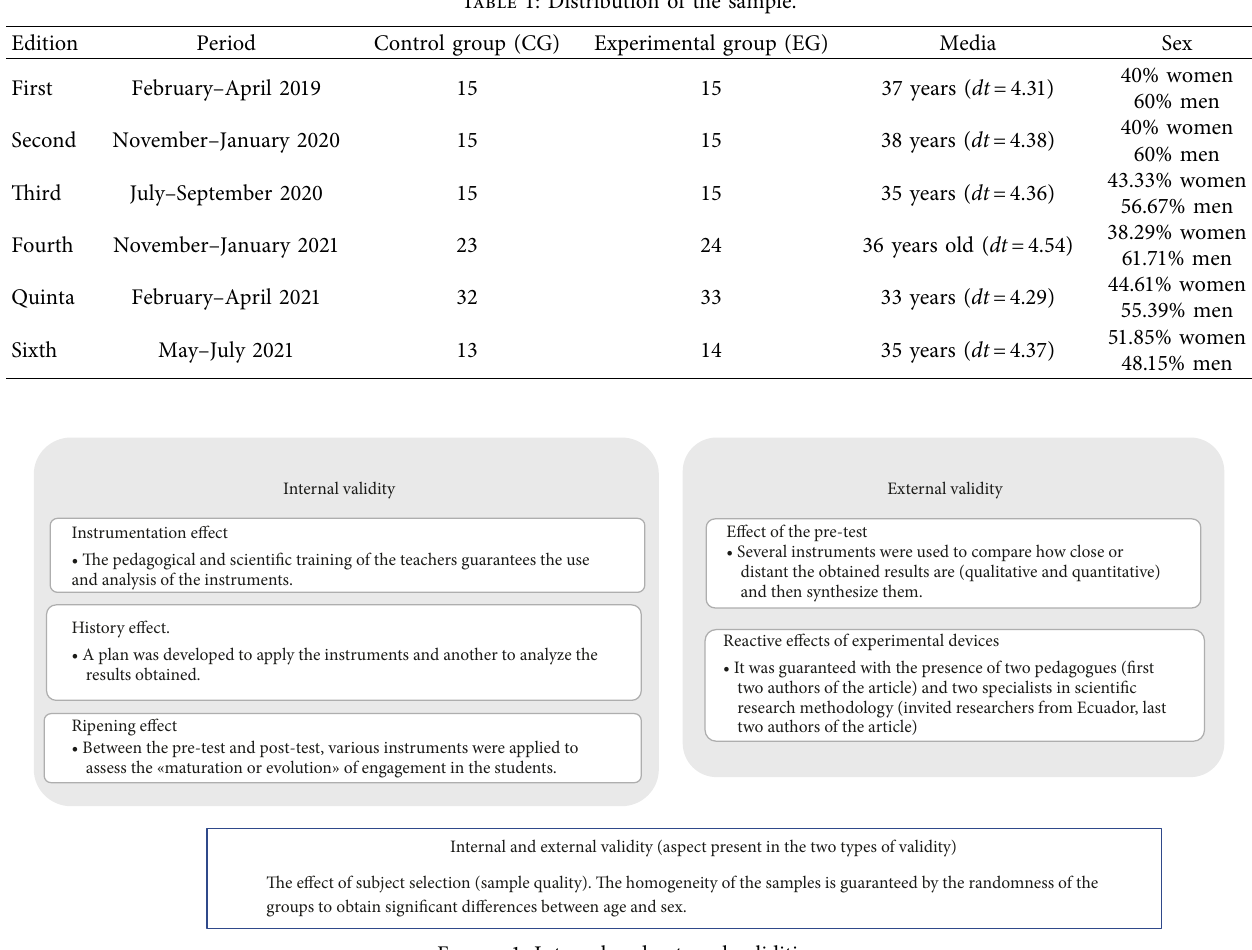
Figure 1: Internal and external